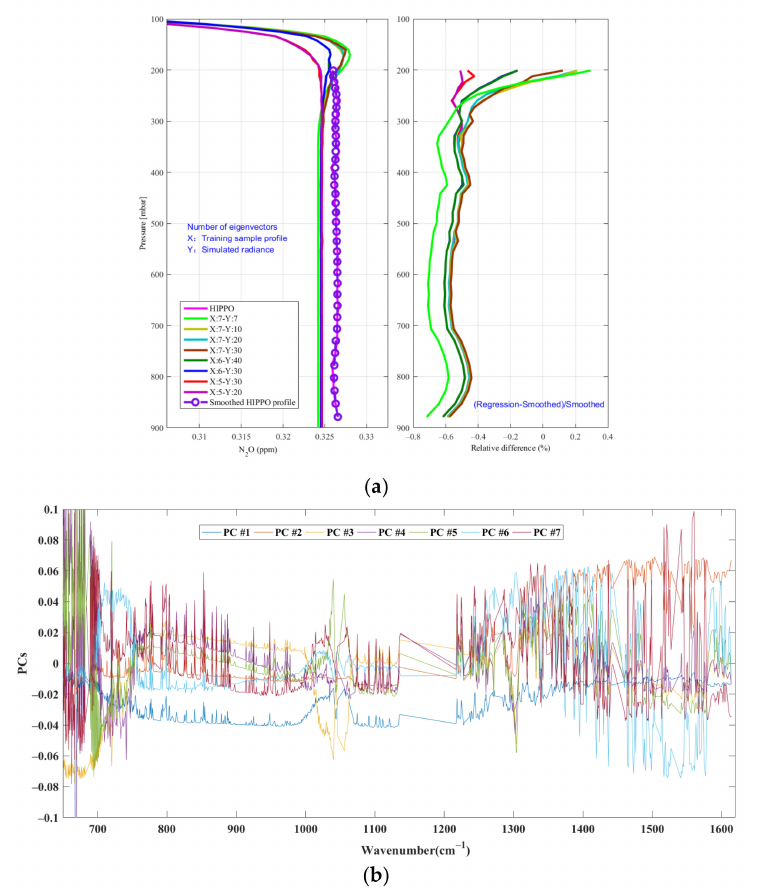
Figure 1. Statistical regression results and seven eigenvectors for simulated BTs. ( a ) Statistical regression results obtained using various numbers of eigenvectors and their relative difference from HIPPO measurement data (time: 10 June 2011). ( b ) Eigenvectors for simulated BTs (in order to draw the continuous line segments, here only part of the bands (650–1620 cm − 1 ) were